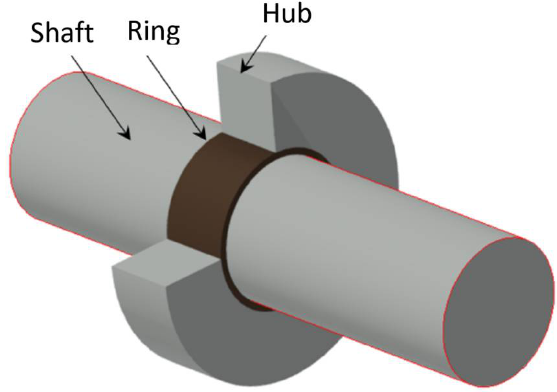
Figure 1. Scheme of a shrink fit using a contact ring.